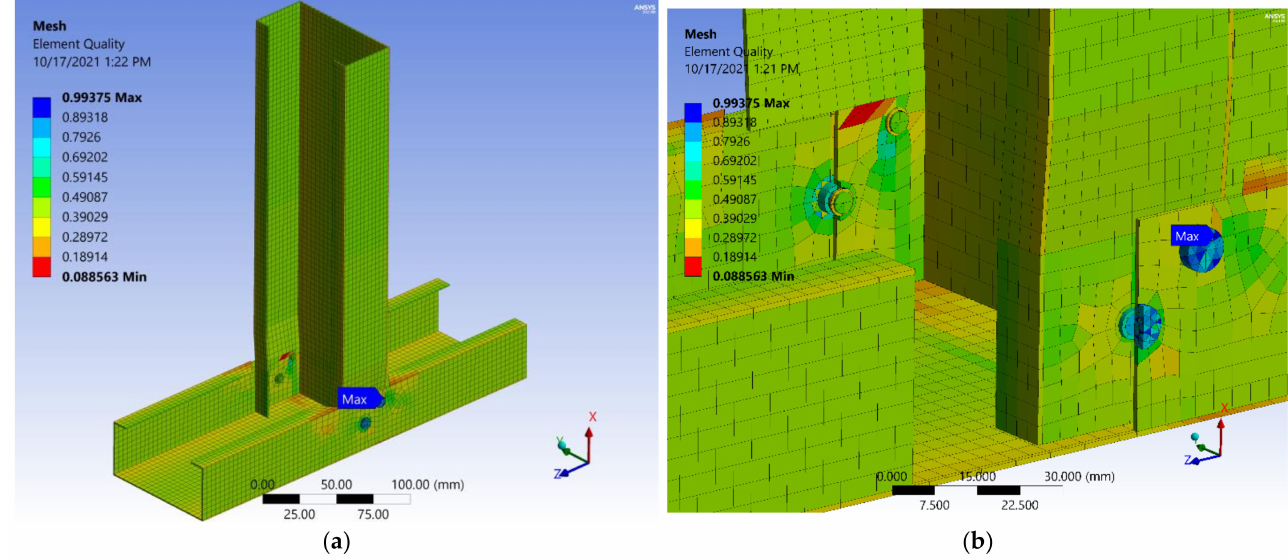
Figure 33. Joint C mesh: ( a ) overall; ( b ) details of screws with hidden parts.